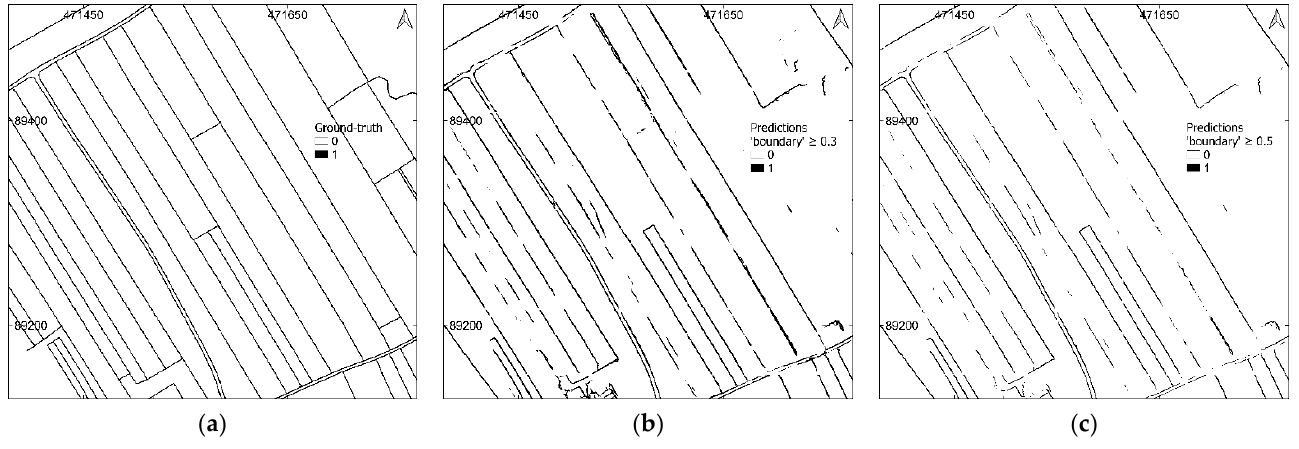
Figure 7. ( a ) Ground truth image for Ponova vas, Slovenia. ( b , c ) Reclassified boundary maps obtained with customised CNN: ( b ) with threshold “boundary” ≥ 0.3, and ( c ) with threshold “boundary” ≥ 0.5.